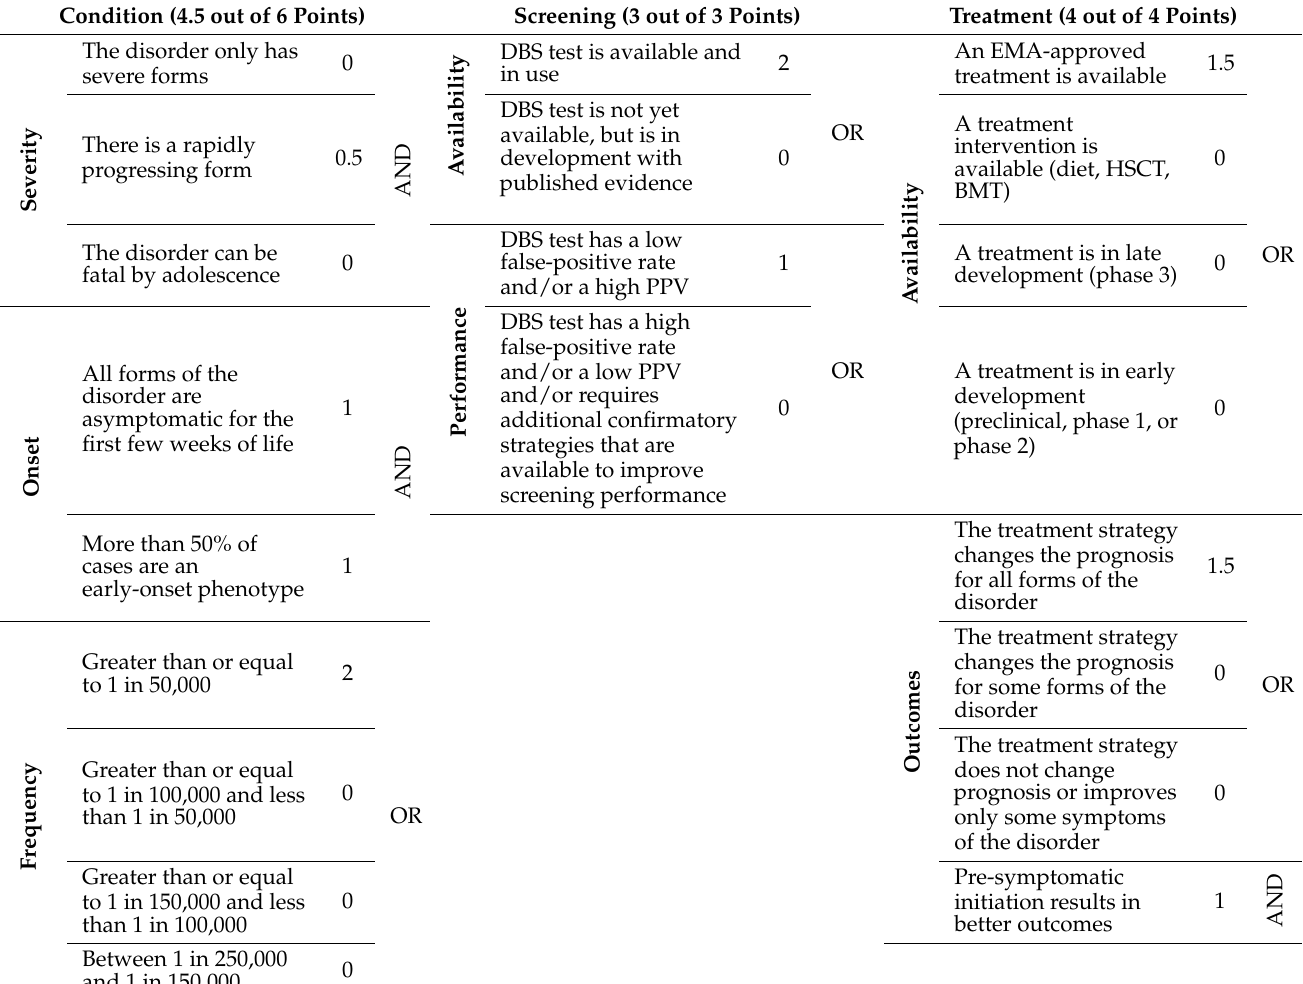
Table A11. Phenylketonuria (PKU) 11.5